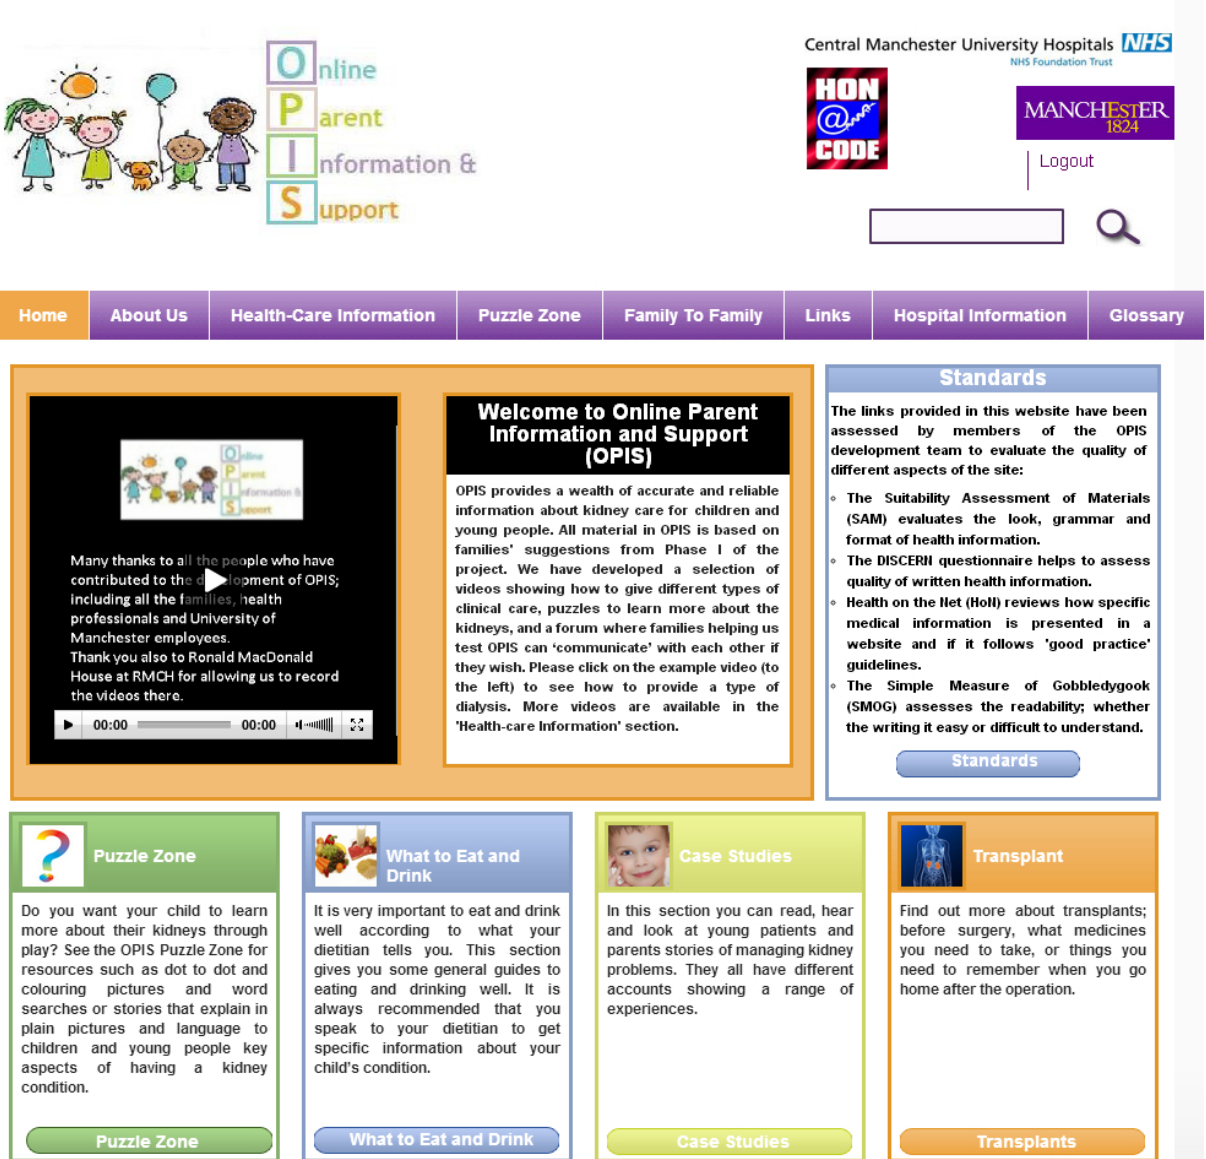
Figure 2. Screenshot of OPIS